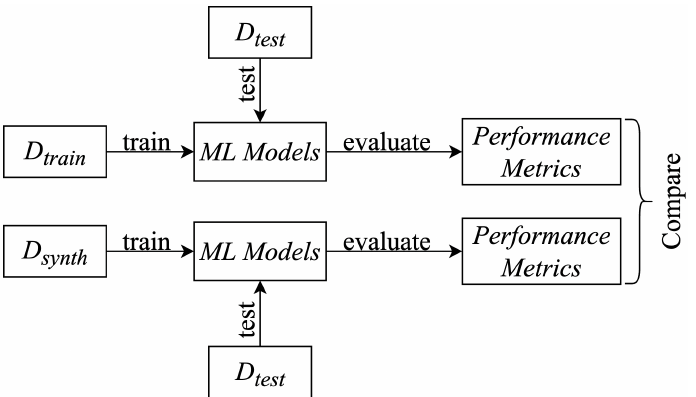
Figure 25. Machine learning efficacy diagram. The performance (accuracy, F1-score, etc.) of ML models (random forests, decision trees, etc.) in the test set, D test , is compared when the models are trained on the real training data, D train , and when they are trained using the synthetic data, D synth .